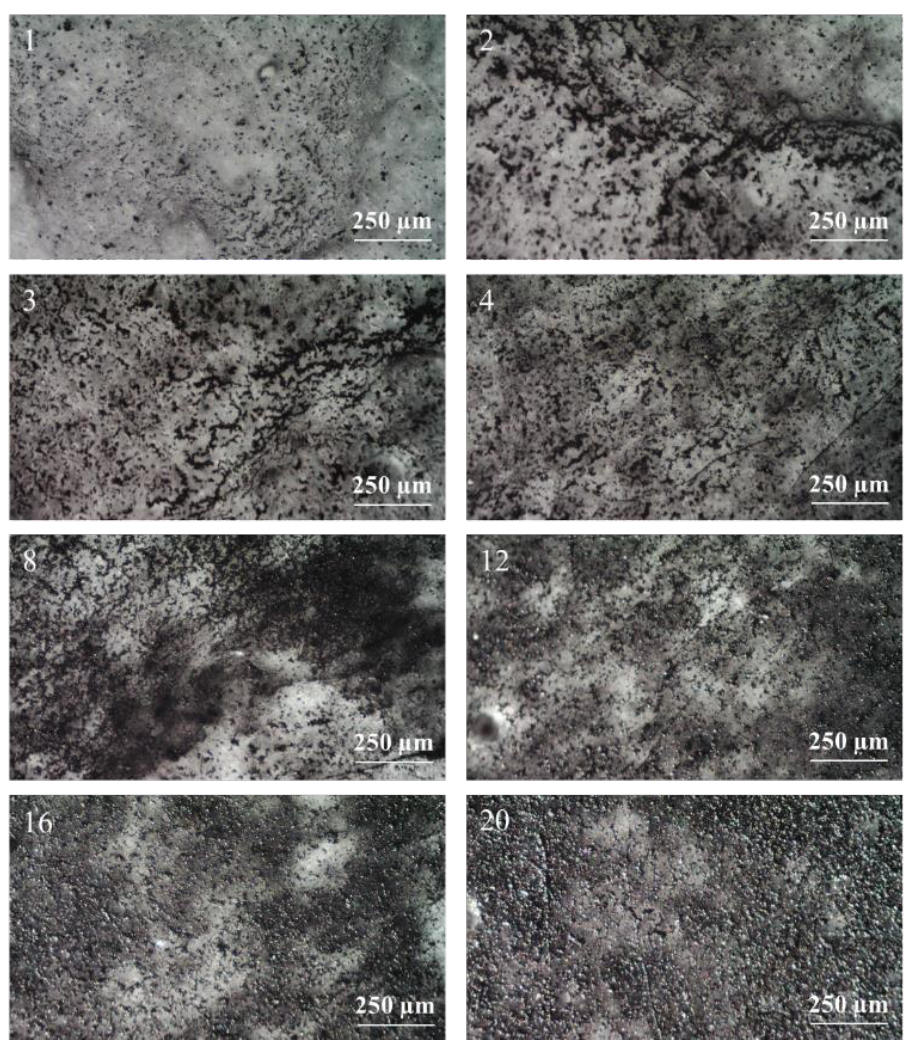
Figure 16. Optical microscope images of spin-coated MWCNT films on photo paper with varying layer counts (1–20 as labeled in each panel), showing visible agglomerates.